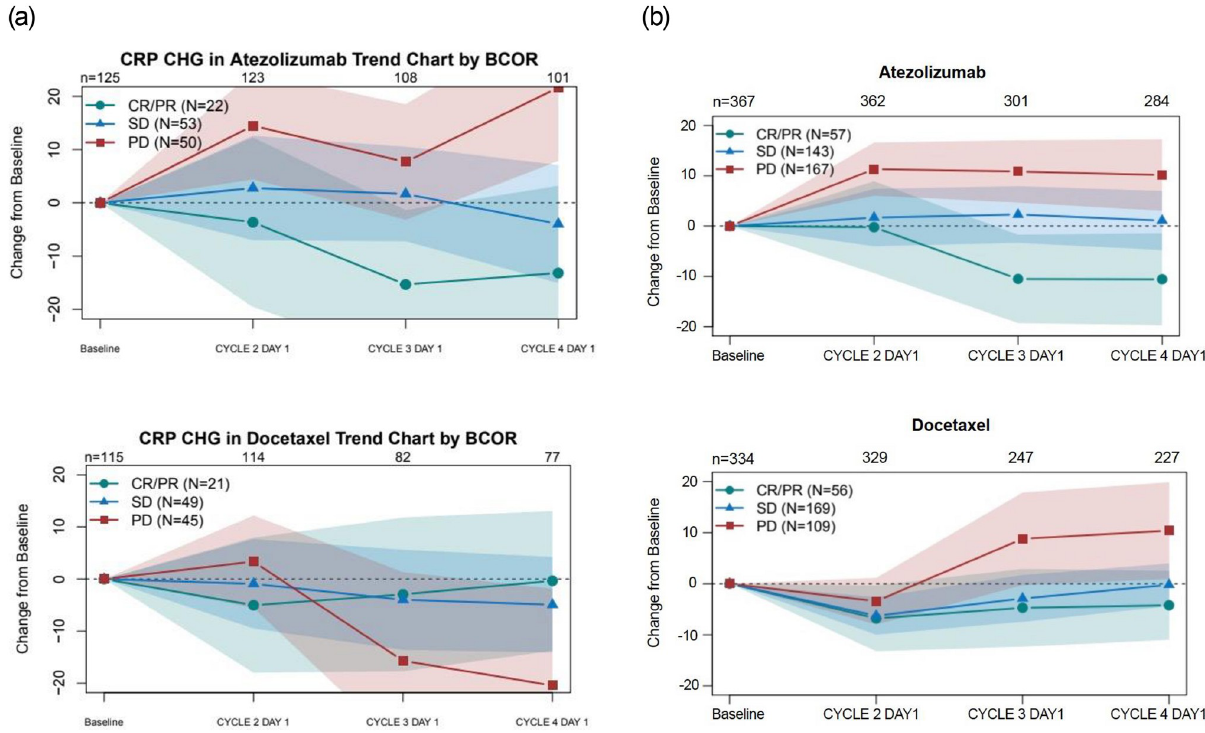
Fig 1. Modulation of CRP relative to pre-treatment is associated with overall response post atezolizumab treatment but not with docetaxel treatment in the POPLAR and OAK studies. A. POPLAR Studies B. OAK Studies. Trend plots of CRP change from baselines of patients in different response categories in both the POPLAR and OAK study using simple means for each visit separately. Shaded regions indicate point-wise 95% confidence intervals. n: number of patients with a change from baseline value at a particular visit, excluding patients with missing or not evaluable best confirmed overall response. N: number of patients at baseline in each best confirmed overall response